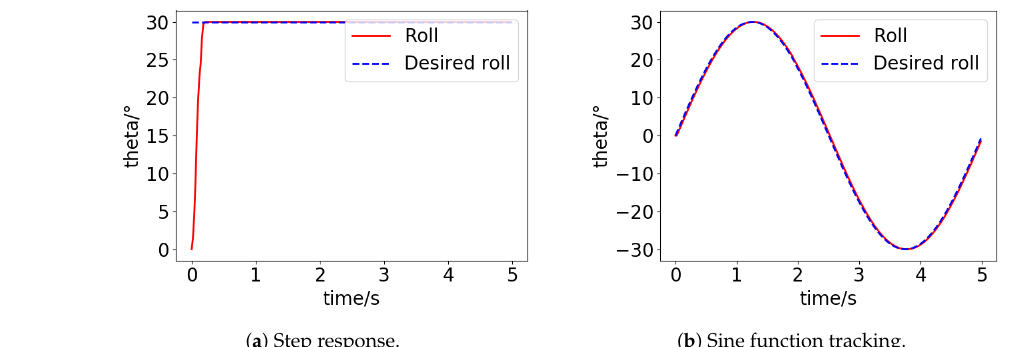
Figure 6. Performance along the roll